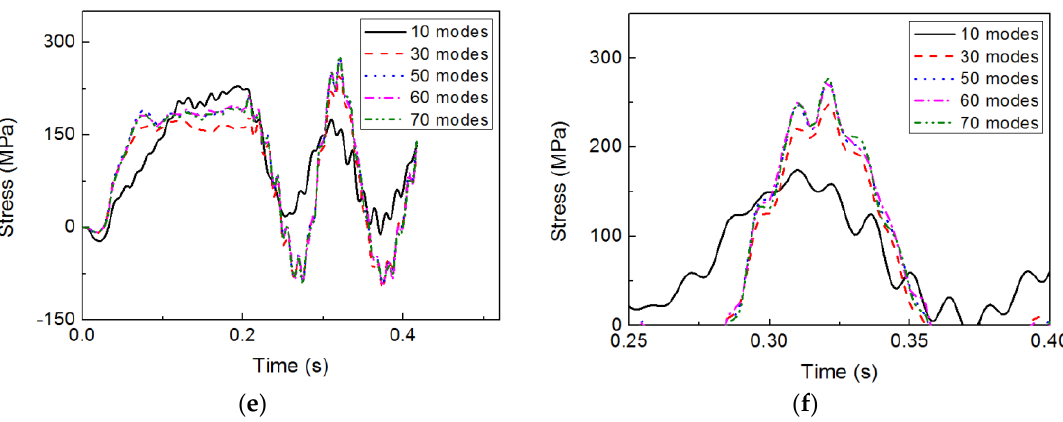
Figure A3. Dynamic response with different number of modes. ( a ) entire simulation of S3; ( b ) near the maximum stress of S3; ( c ) entire simulation of S5; ( d ) near the maximum stress of S5; ( e ) entire simulation of S7; ( f ) near the maximum stress of S7.